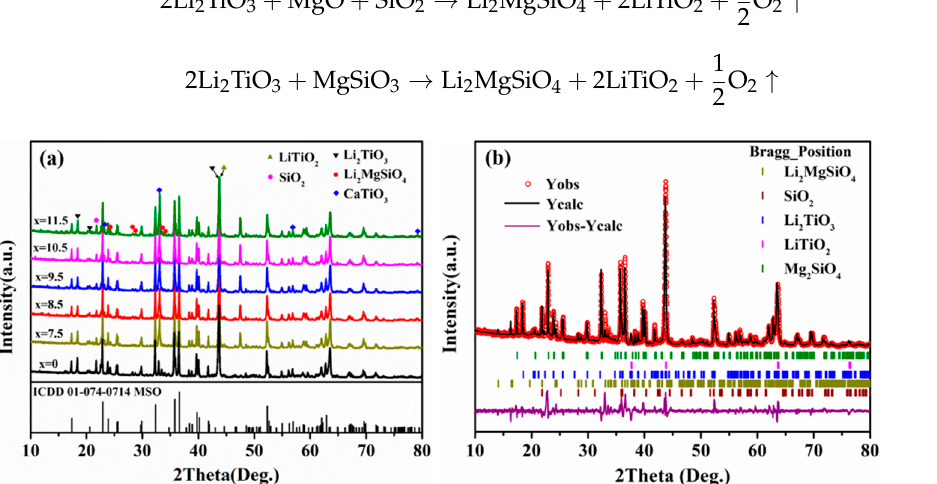
Figure 2. ( a ) XRD patterns of the MLLC ceramics sintered at 800 °C. ( b ) Rietveld refinement plots of the MLL ceramic.